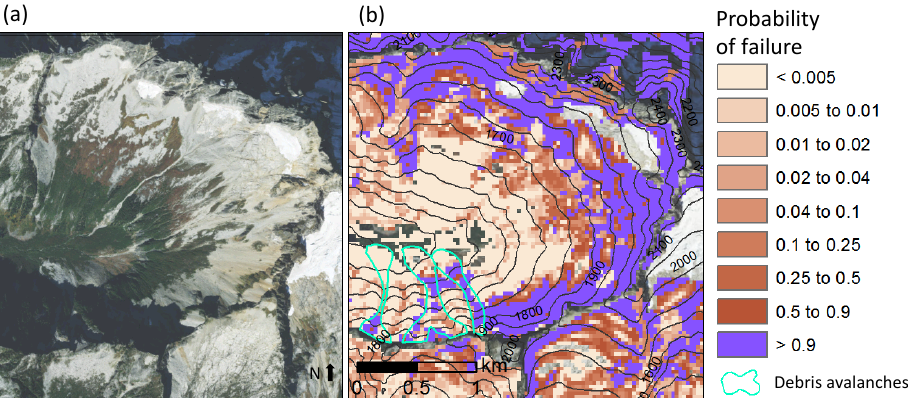
Figure 9. Illustration of highly unstable steep areas: (a) high-resolution (0.3m) imagery of a NOCA mountain compared to (b) P ( F ) simulated by M-SD with mapped debris avalanches. Imagery from World Imagery, Esri Inc., created using ArcGIS ® software by Esri. ArcGIS ® and ArcMap ™ are the intellectual property of Esri and are used herein under license. Copyright Esri©. All rights reserved. For more information about Esri© software, please visit www.esri.com. Contours at 100m. Notice the barren areas below retreating glaciers with high P ( F ).